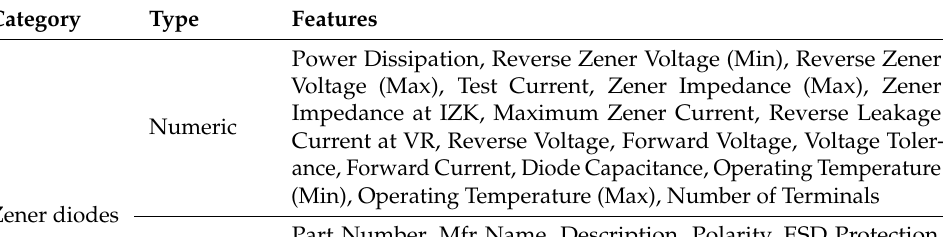
Table 1. Features of the diode data from three